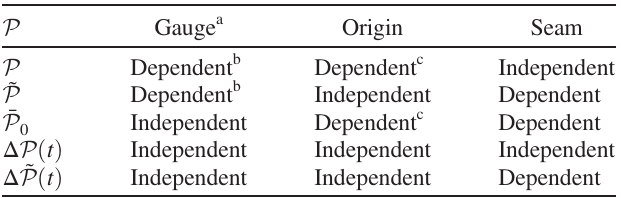
TABLE I. Properties of the many-body Berry phases P and defined in Eqs. (10) and (13), Berry phases in Eqs. (23) and